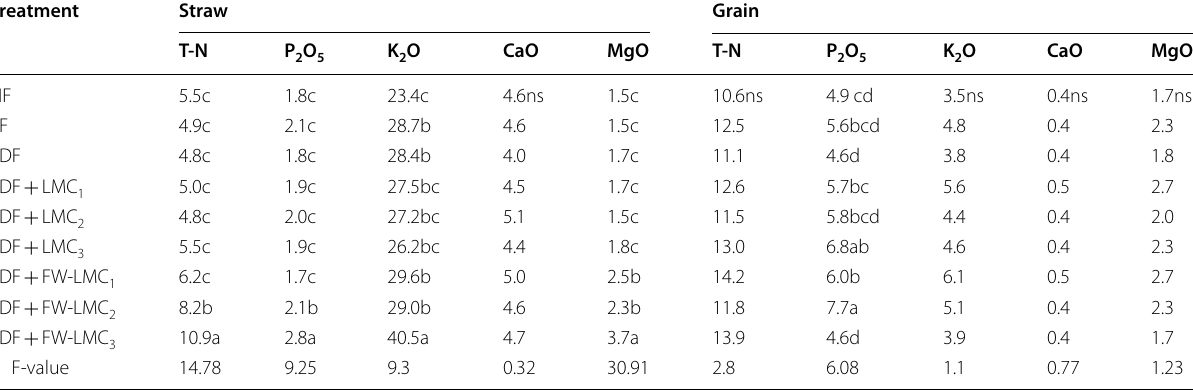
(SDF 100, 150 and 300% LMC), + − 3